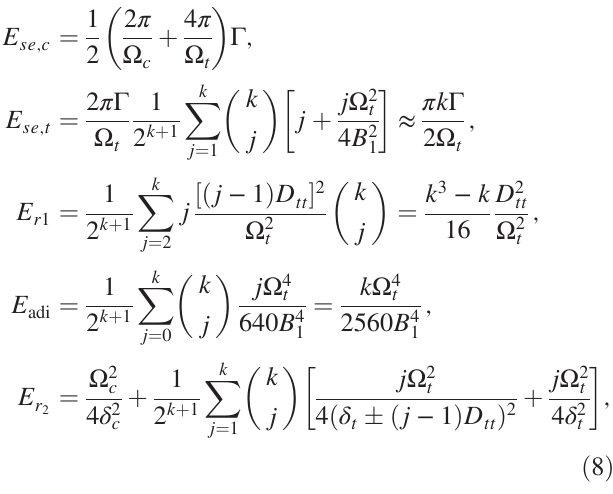
FIG. 4. Total infidelity of dark-state gates vs (a) atomic separation and (b) number of qubits k (we use Rydberg states j 101 S; 109 S i of Cs atoms with intracomponent and intercompo- nent interaction coefficients given in Table I in Appendix A). In panel (a), gates with k ¼ 6 (solid lines) and k ¼ 20 (dashed lines) are carried out at the environment temperature of T ¼ 77 K. In panel (b), filled circles represent the analytical error estimate in Sec. IV, while crosses show more elaborate estimates determined with atoms located on a square lattice; see Appendix C. All the dynamical parameters are optimized for each